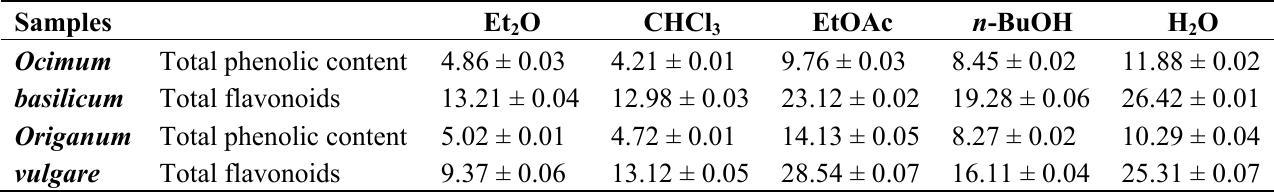
Table 1. The amount of total phenolic contents and content of total flavonoids in O. basilicum and O. vulgare